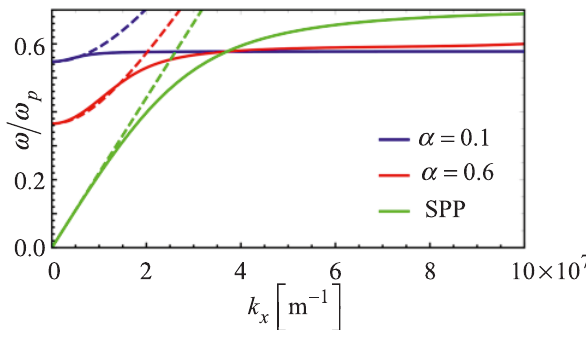
Figure 3: Dispersion of the surface plasmons for α = 0.1 and α = 0.6 together with dispersion of the pure metal-vacuum surface plasmon plotted against k x in units of m − 1 . The dotted lines show the associ- ated light lines in the dielectric.